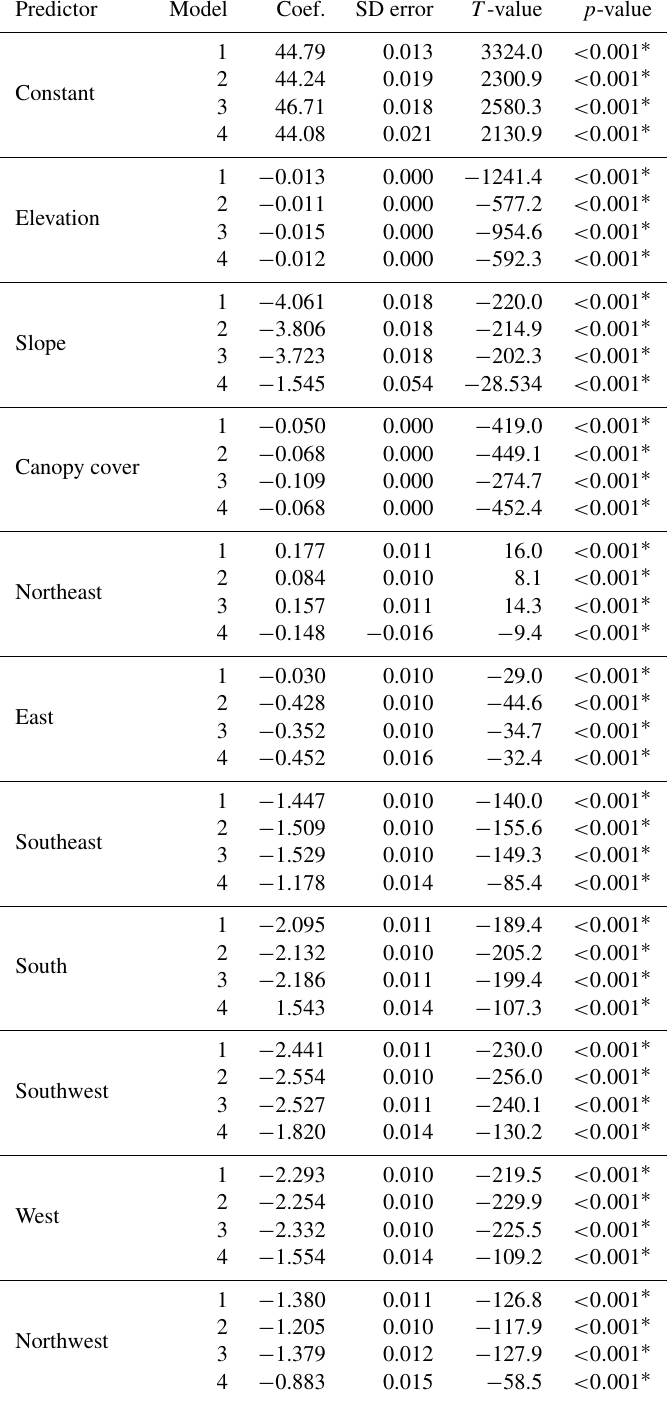
Table B1. Summary of regression coefficients in the analysis of land surface temperature (LST) from the four models tested. ∗ Indicates statistical